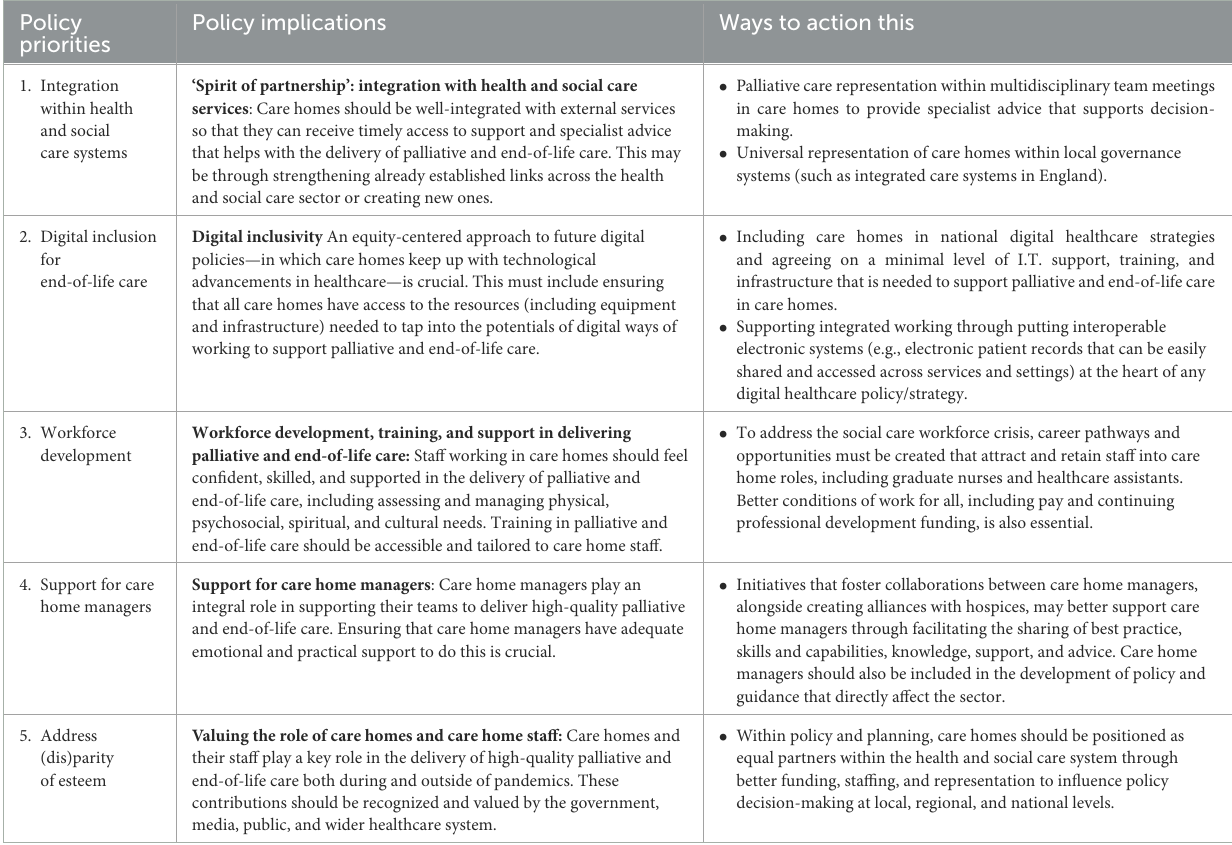
TABLE 3 Policy priorities for the provision of palliative and end-of-life care in care